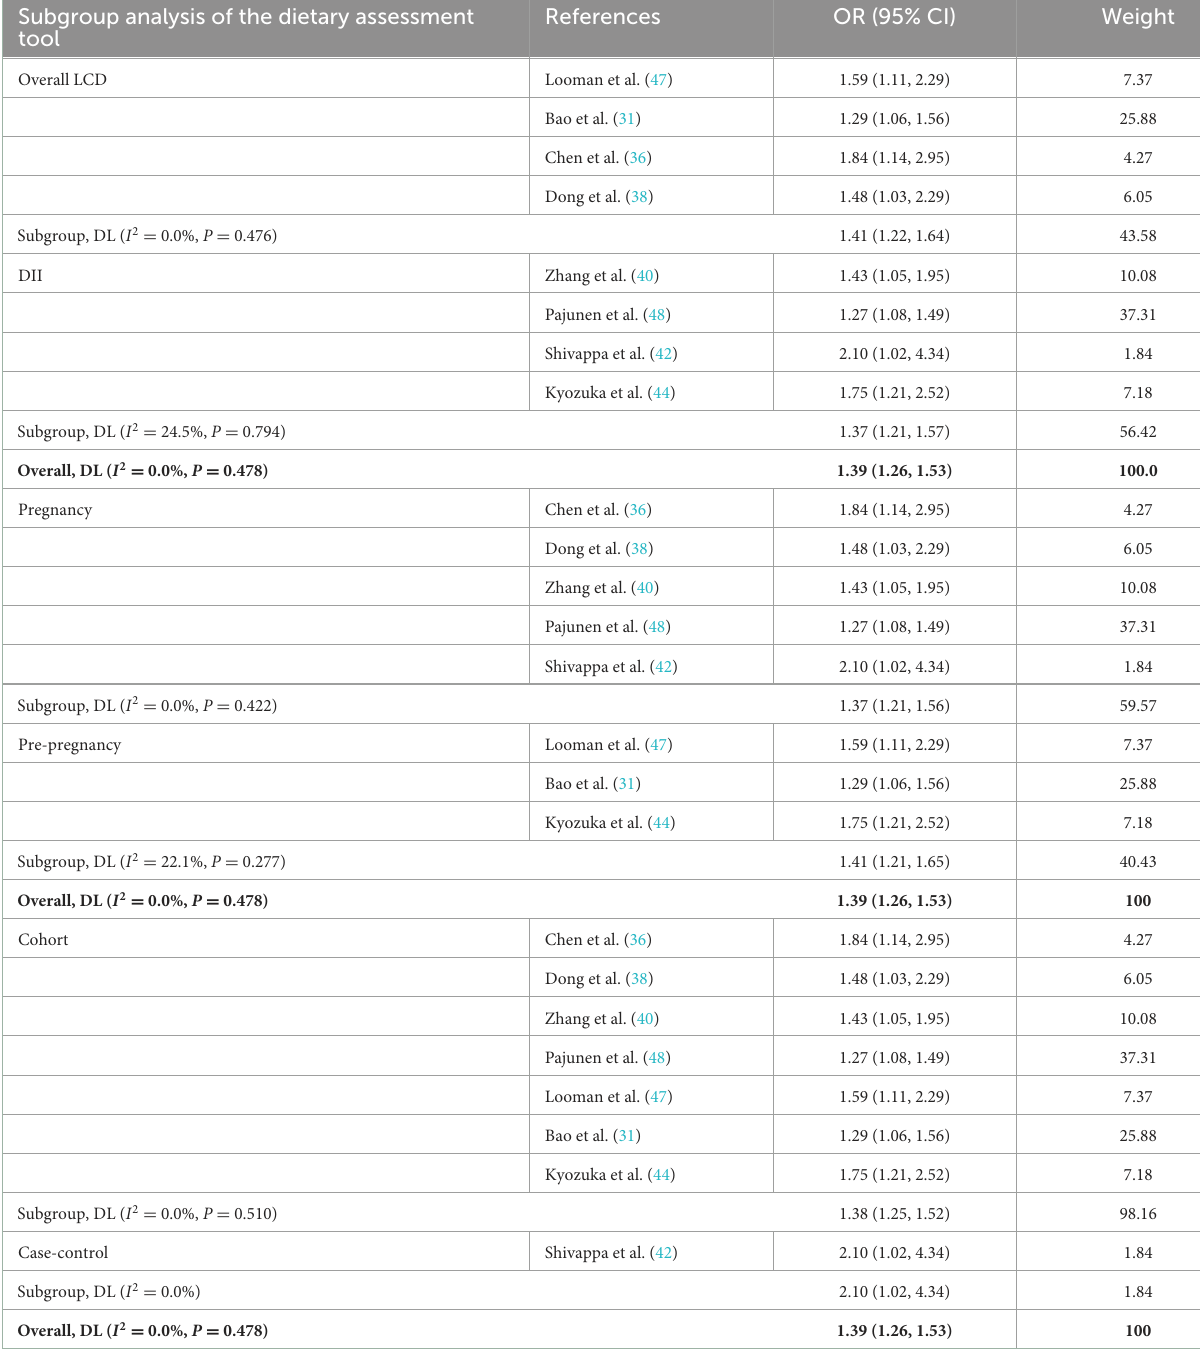
TABLE 4 Subgroup analysis of the Group B (including dietary assessment tools, participants, and study design). Subgroup analysis of the dietary assessment